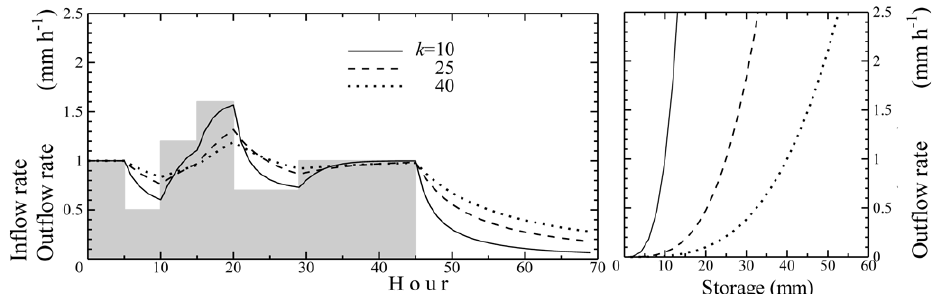
Fig. 3. Schematic example of outflow rates calculated by TANK in response to fluctuations in the inflow rate around the average of 1mmh − 1 and their recession limbs after the inflow stops (left panel). The functional relationships between storage and the outflow rate used in the calculations in the left panel are displayed in the right panel. The common p value of 0.3 and the three k values described in the left panel were used for the TANK